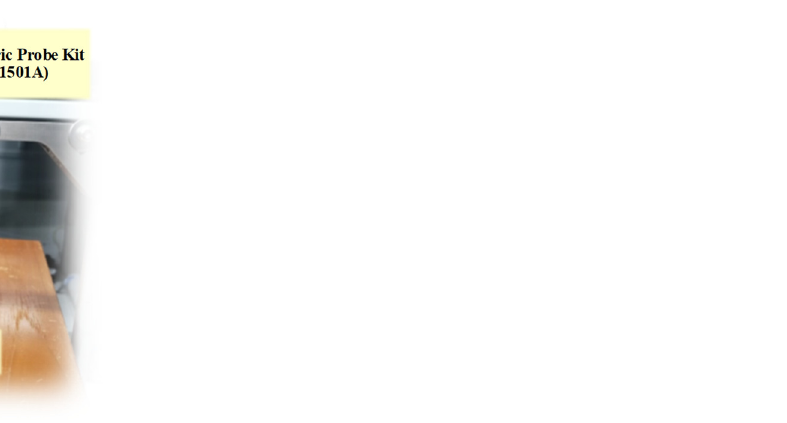
( c ) Figure 12. Prototype of the MICS/ISM meander-line microstrip antenna: ( a ) front view, ( b ) rear view, ( c ) in the glass pod. Table 5. The concentrations of syrup, salt, and water in nine experimental mixtures of equivalent liquid. Mixture